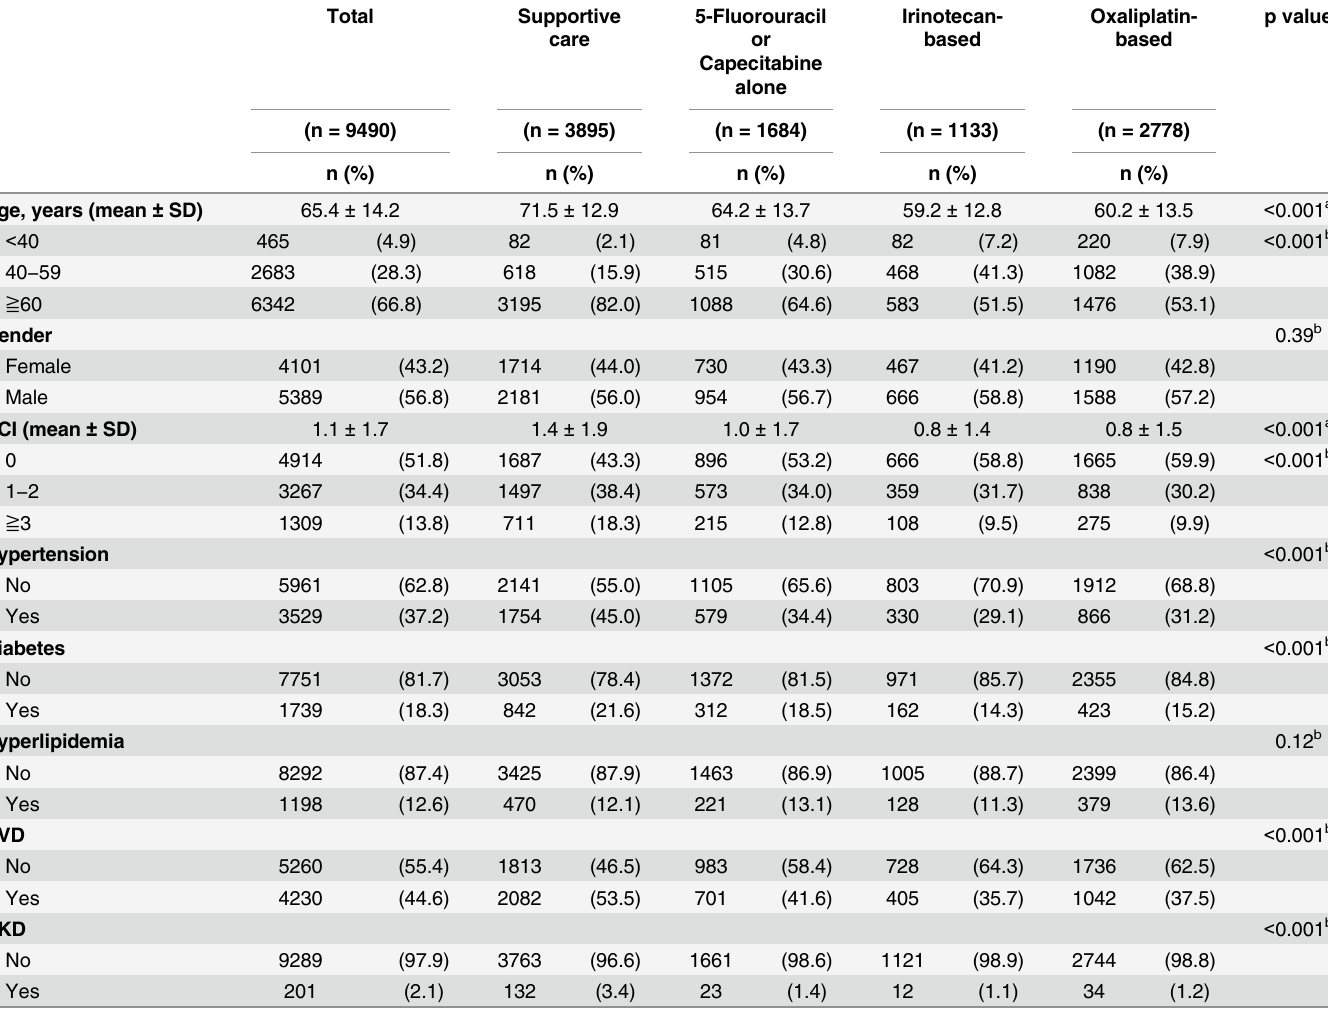
Table 1. Comparison of Clinical Characteristics of Metastatic Colorectal Cancer Patients According to Front-line